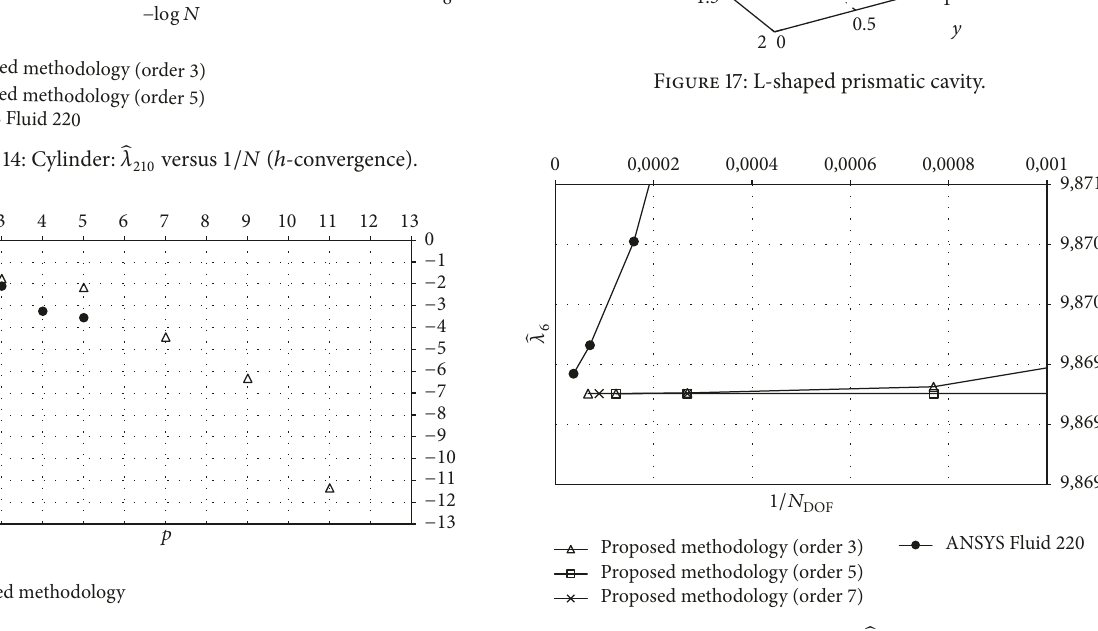
Figure 18: L-shaped cavity: